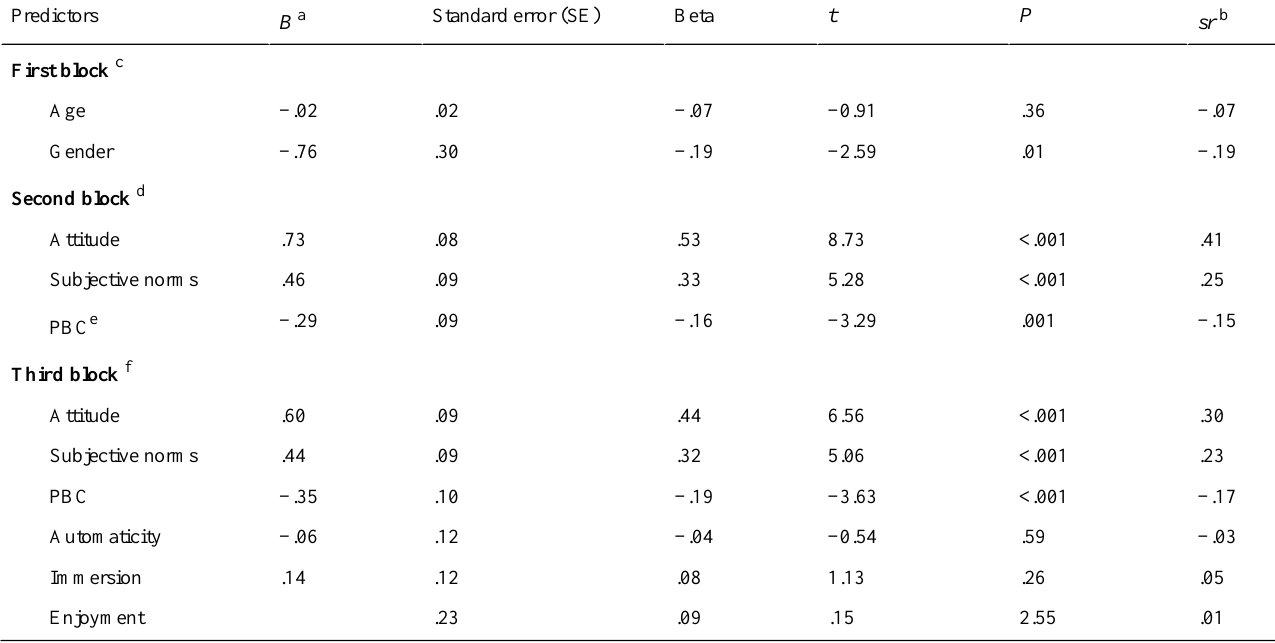
Table 6. Regression results for intention to play a mobile game while walking in study 2